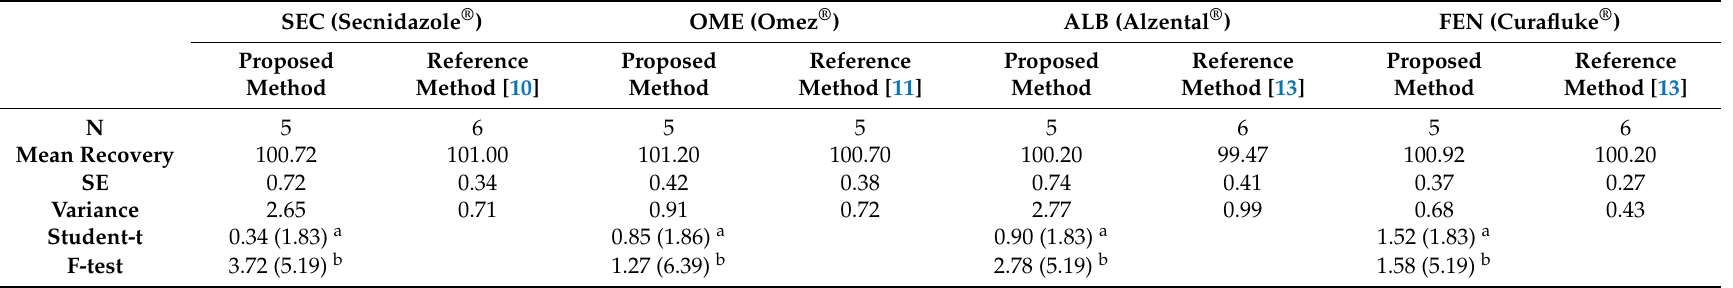
Table 7. Statistical analysis of results obtained by the proposed method applied on Secnidazole ® , Omez ® , Alzental ® , and Curafluke ® dosage forms compared with reference methods.